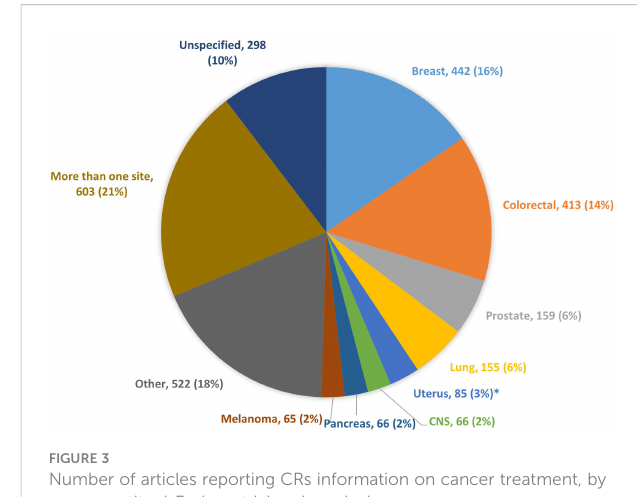
FIGURE 3 Number of articles reporting CRs information on cancer treatment, by cancer entity. * Endometrial and cervical cancers.